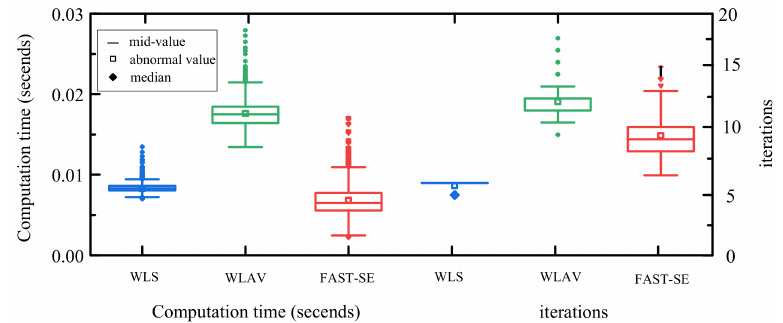
Figure 10. The comparison of computational